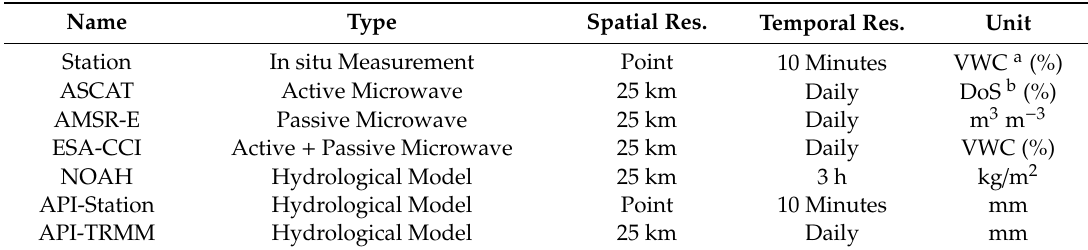
Table 1. Information on used soil moisture data